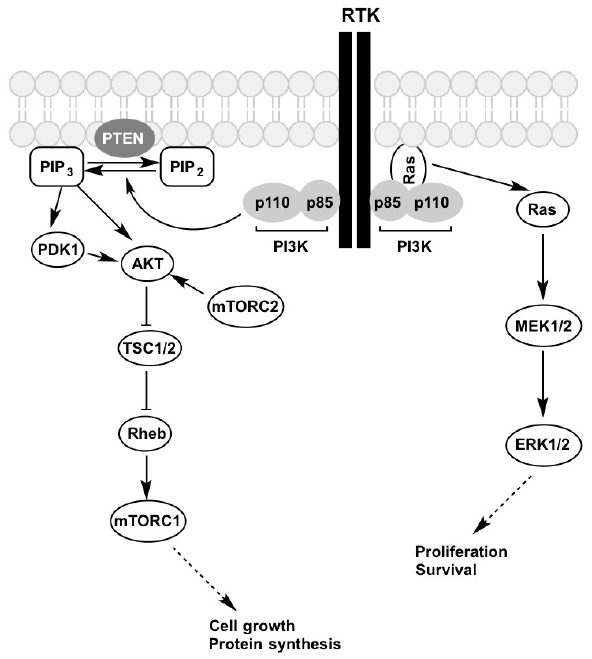
Figure 2. Growth factor activation of the PI3K-AKT-mTOR and MAPK signalling pathways. Figure is adapted from [67]. Description of the abbreviations listed above are contained within this review.